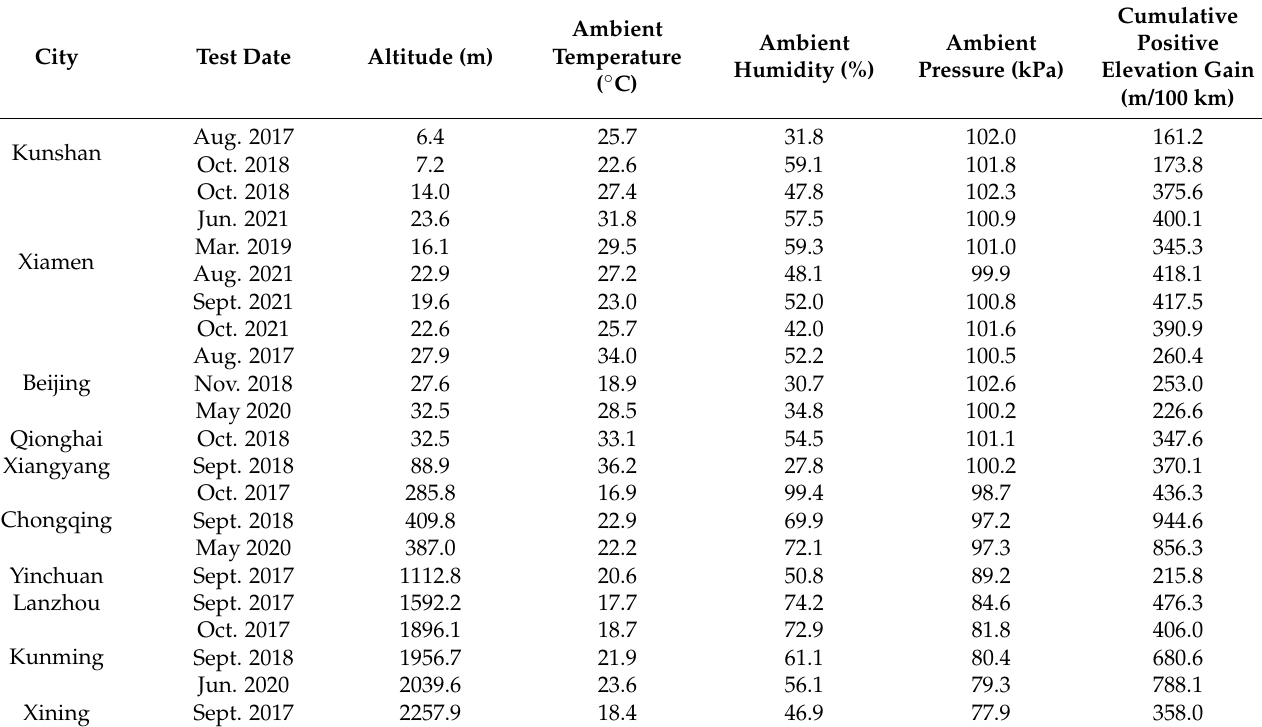
Table 2. Boundary